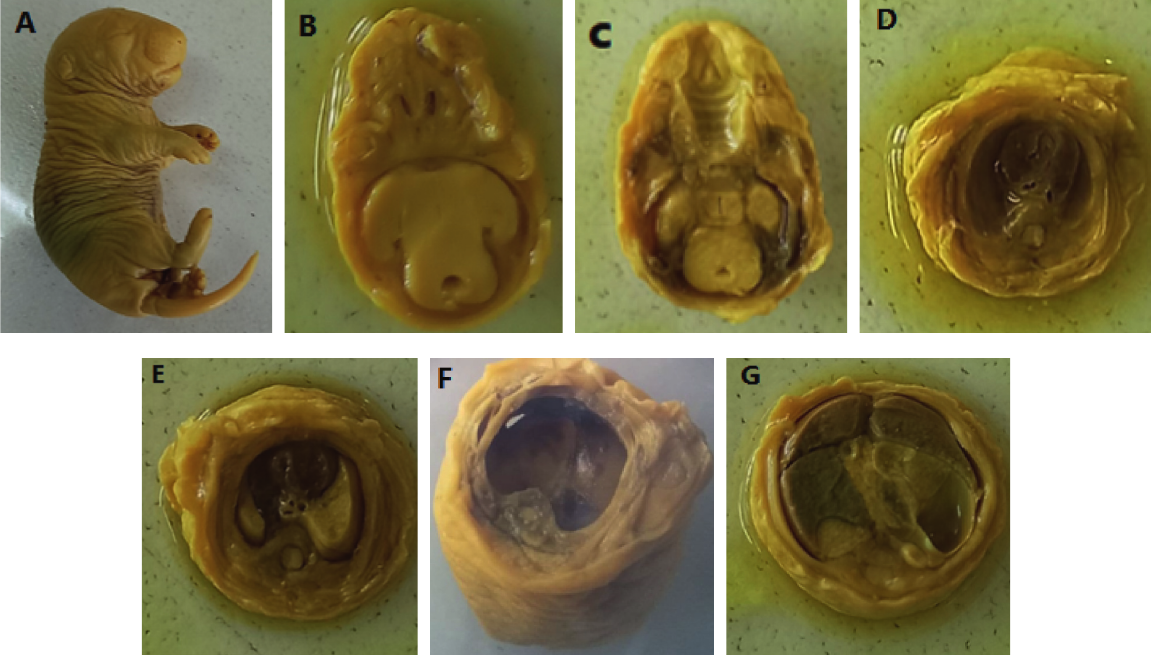
Figure 4: A 20-day-old rat fetus fixed in Bouin’s solution for visceral examination (260 mg/kg). (a) Unsectioned fetus; (b) transverse section of the brain showing normal brain tissue; (c) normal palate; (d) a section made through the neck showing the normal esophagus, trachea, and thyroid gland; (e) a section made through the chest showing normal; (f) intact diaphragm; and (g) a section made through the abdomen showing normal visceral organs. Table 9: Skeletal malformations of a 20-day-old rat fetuses following treatment with the essential oil of Thymus schimperi .